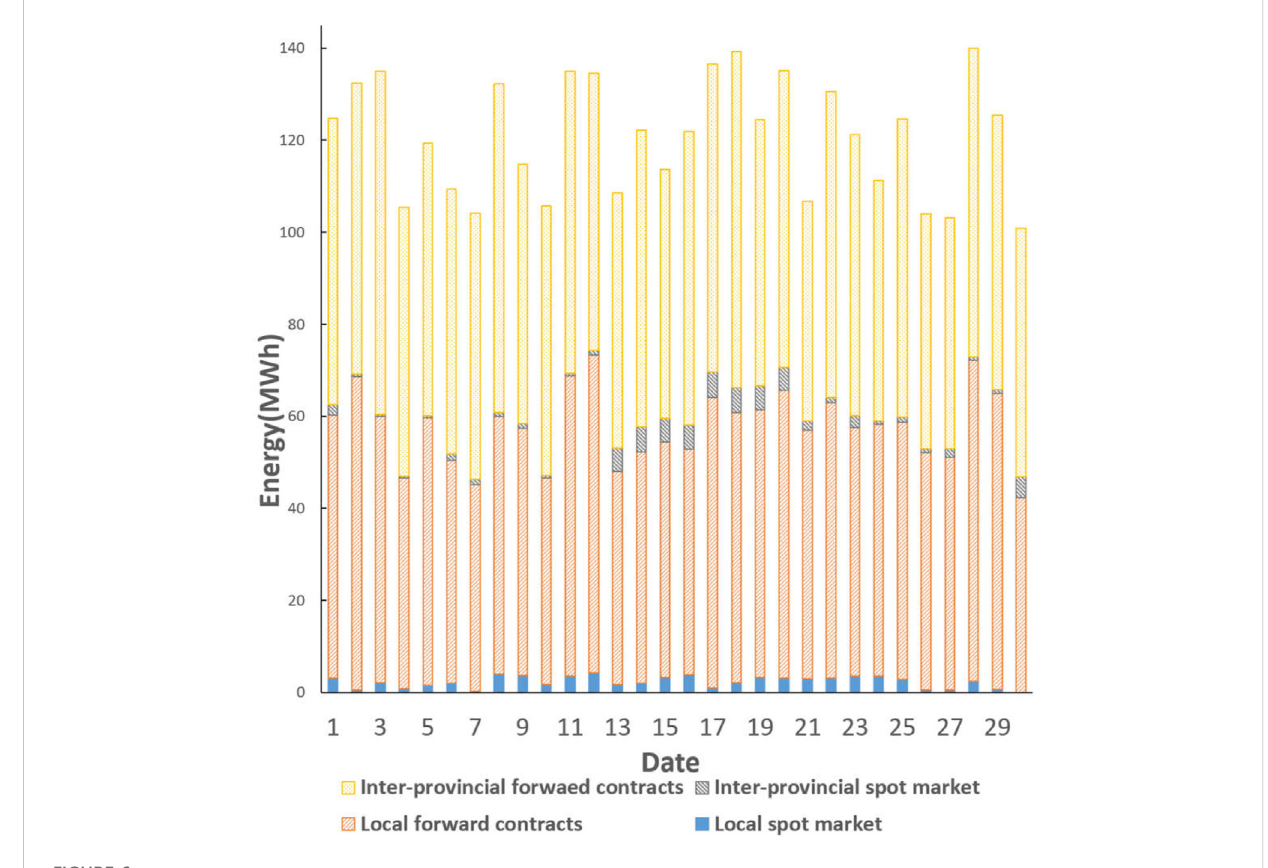
FIGURE 6 Result of optimized allocation of the energy portfolio.